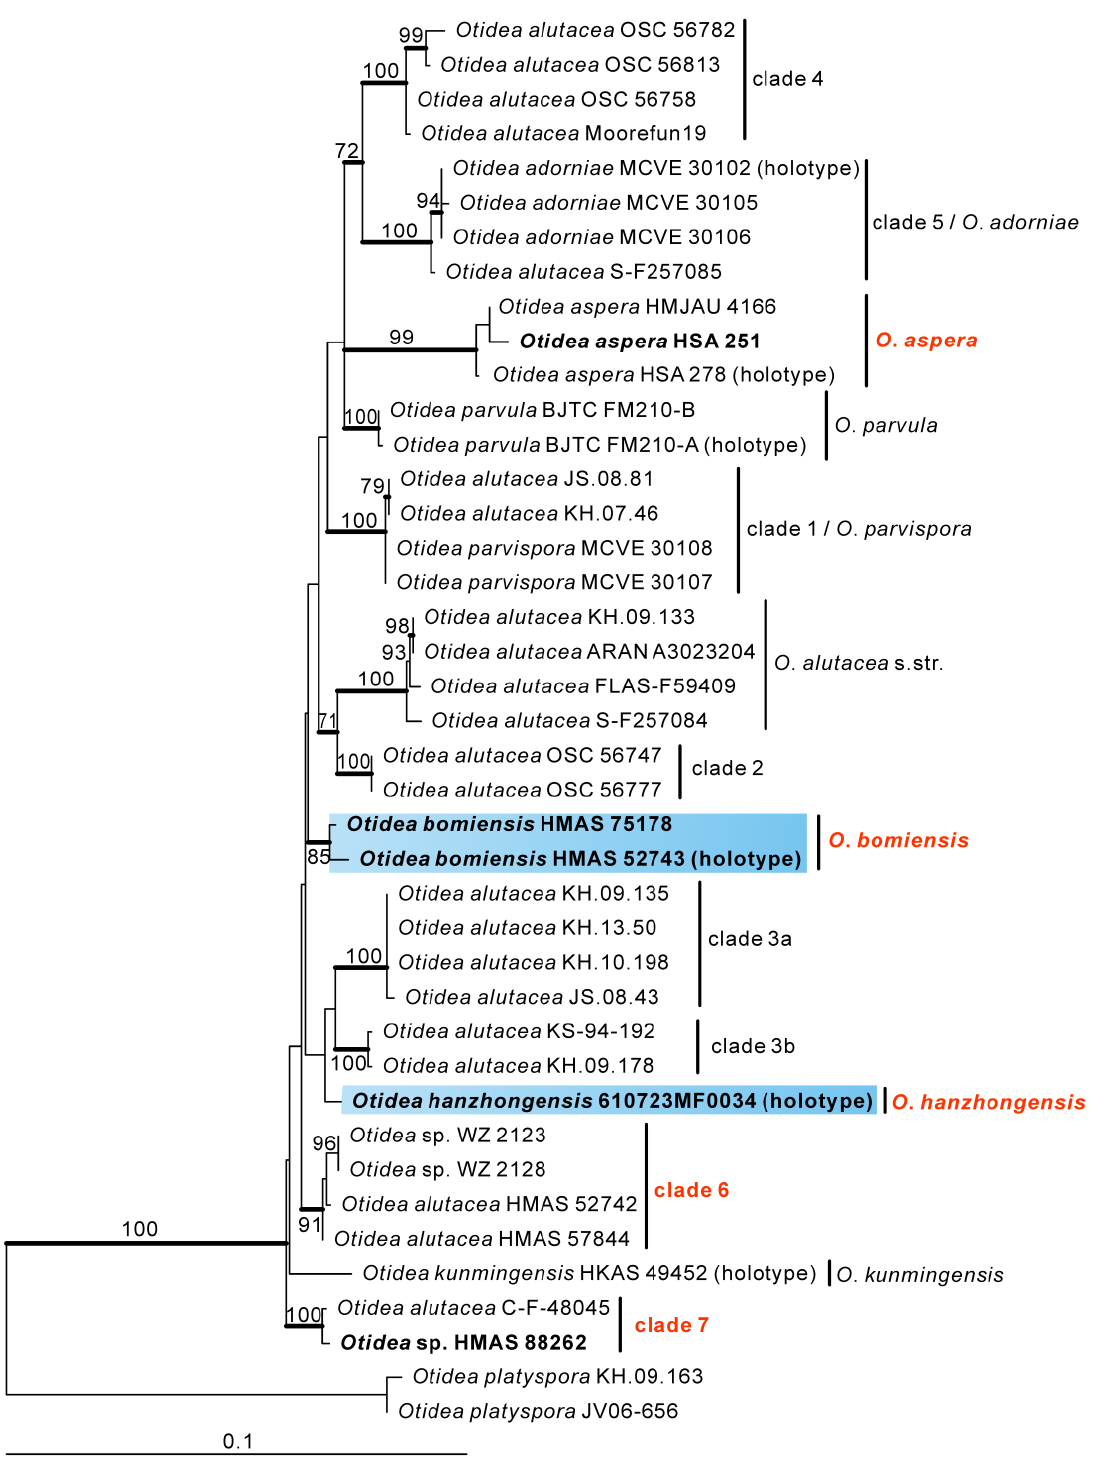
Figure 3. Phylogeny of the O. alutacea clade derived from maximum likelihood analyses of the combined (ITS-LSU) dataset. Otidea platyspora was used to root the tree as the outgroups. Maximum likelihood bootstrap support (BS ≥ 50%) is shown on the nodes. Branches with Bayesian posterior probabilities (PP) ≥ 0.95 and new sequences are in bold.